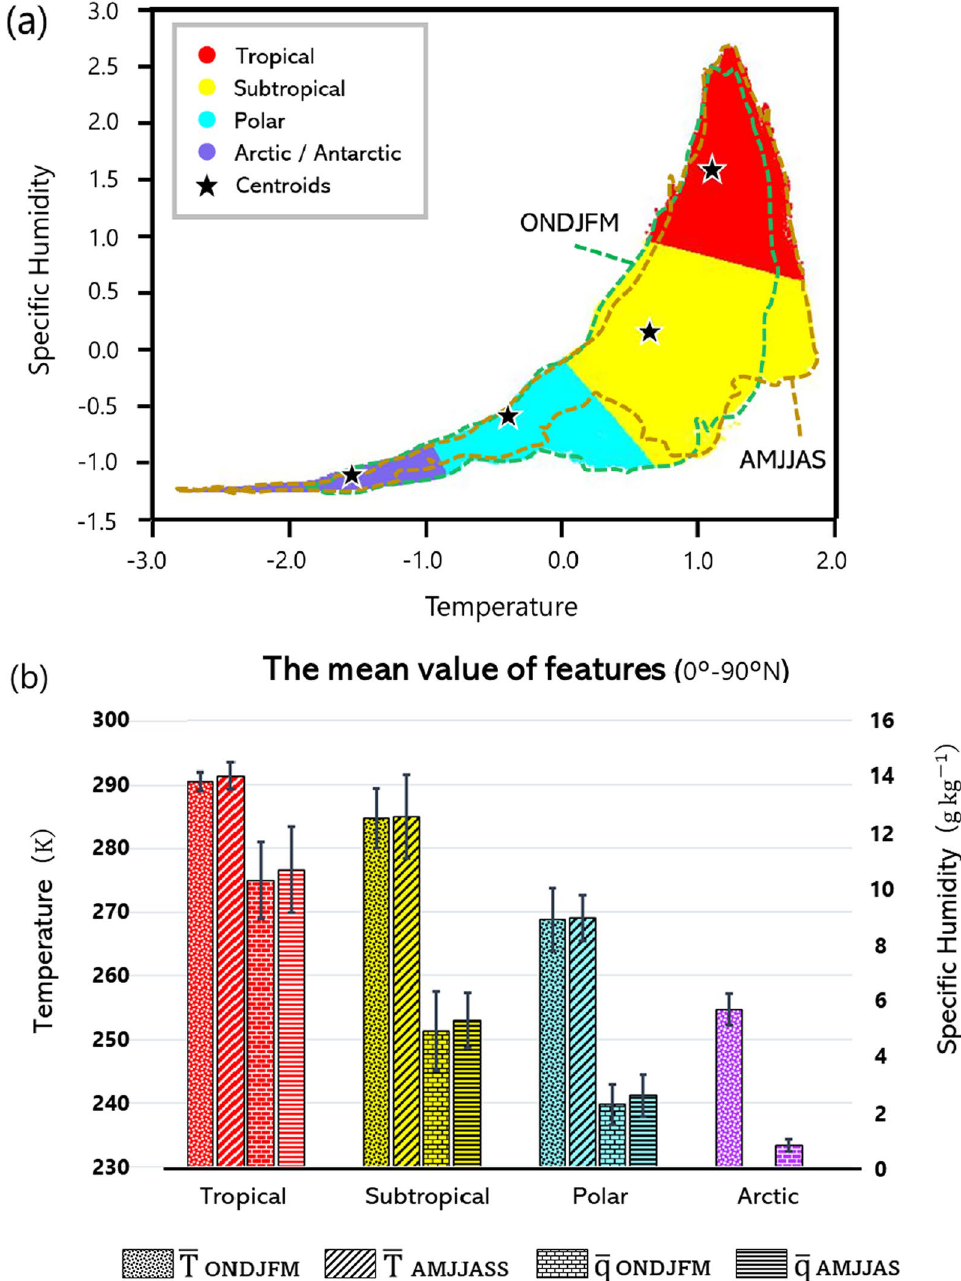
Fig. 6 ( a ) Distribution and centroid in feature space of the global air mass zones, and ( b ) the mean values (error bars: standard deviations) of the temperature and specific humidity in each air mass zone for the Northern Hemisphere (0°–90° N) in the O–M and A–S